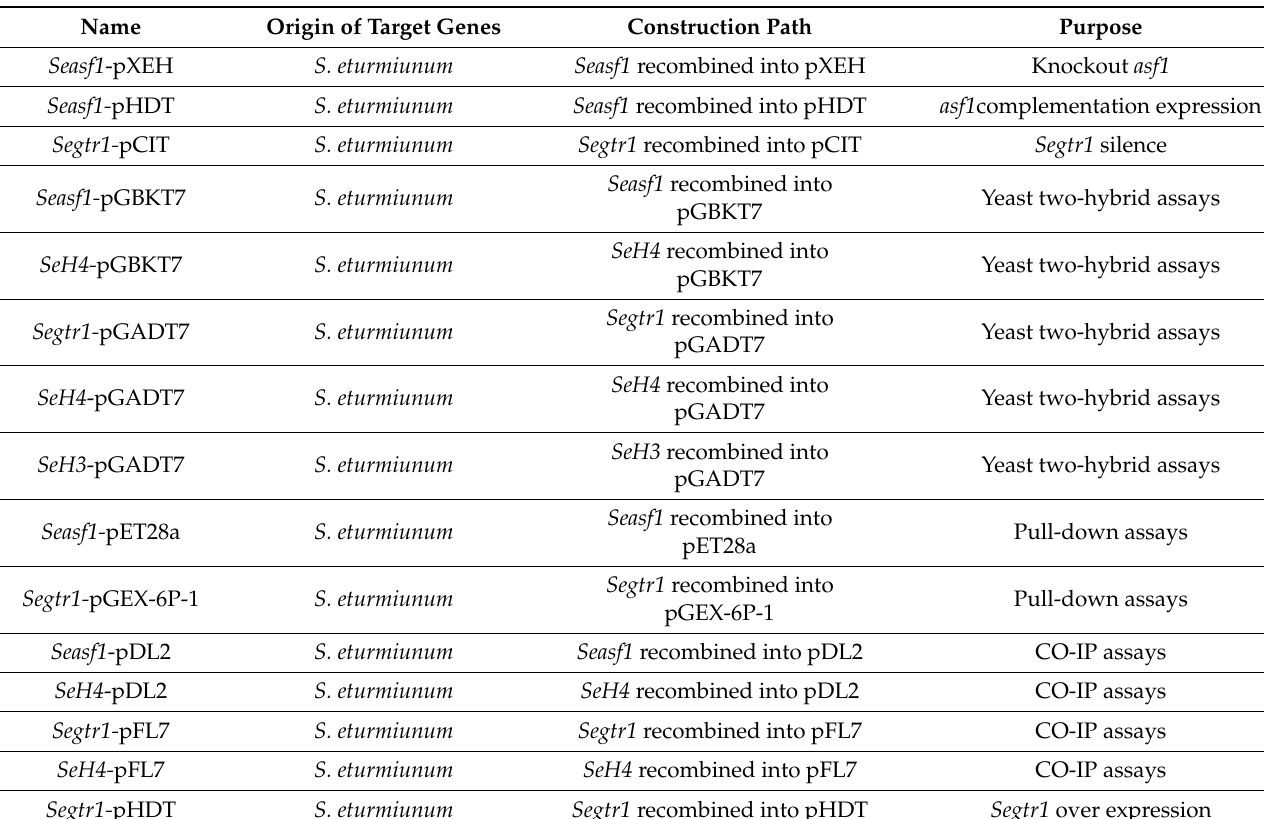
Table 2. Plasmids used in this